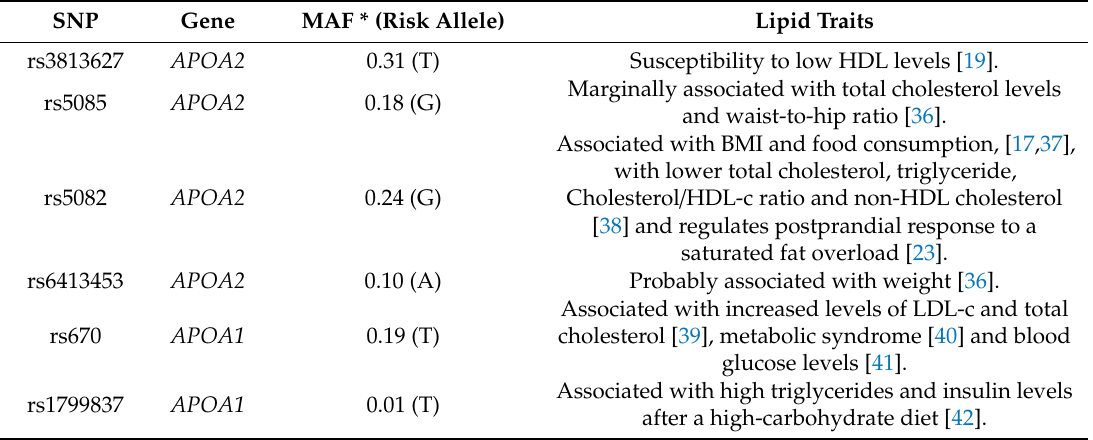
Table 7. General information about SNPs in APOA1 and APOA2 on lipid traits. SNP Gene MAF * (Risk Allele) Lipid Traits rs3813627 APOA2 0.31 (T) Susceptibility to low HDL levels [19]. Marginally associated with total cholesterol levels rs5085 APOA2 0.18 (G) and waist-to-hip ratio [36]. Associated with BMI and food consumption, [17,37], with lower total cholesterol, triglyceride, Cholesterol / HDL-c ratio and non-HDL cholesterol rs5082 APOA2 0.24 (G) [38] and regulates postprandial response to a saturated fat overload [23]. rs6413453 APOA2 0.10 (A) Probably associated with weight [36]. Associated with increased levels of LDL-c and total rs670 APOA1 0.19 (T) cholesterol [39], metabolic syndrome [40] and blood glucose levels [41]. Associated with high triglycerides and insulin levels rs1799837 APOA1 0.01 (T) after a high-carbohydrate diet